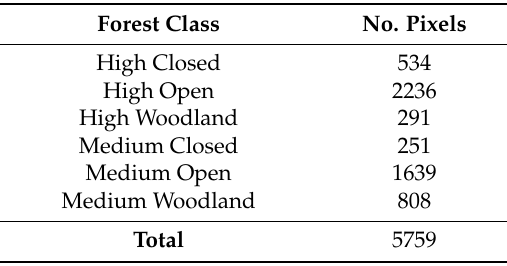
Table 3. Number of reference pixels in each forest class used in this